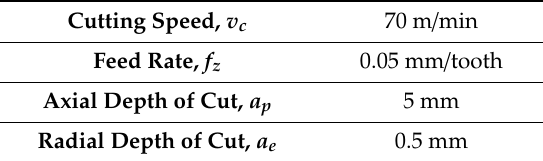
Table 2. Milling operation